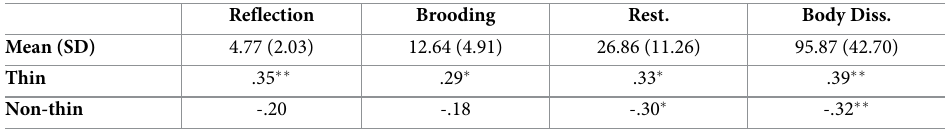
Table 1. Bivariate correlations between AB difference scores for thin and non-thin bodies (ms) with eating disor- der-related correlates ( n = 70). Reflection Brooding Rest. Body